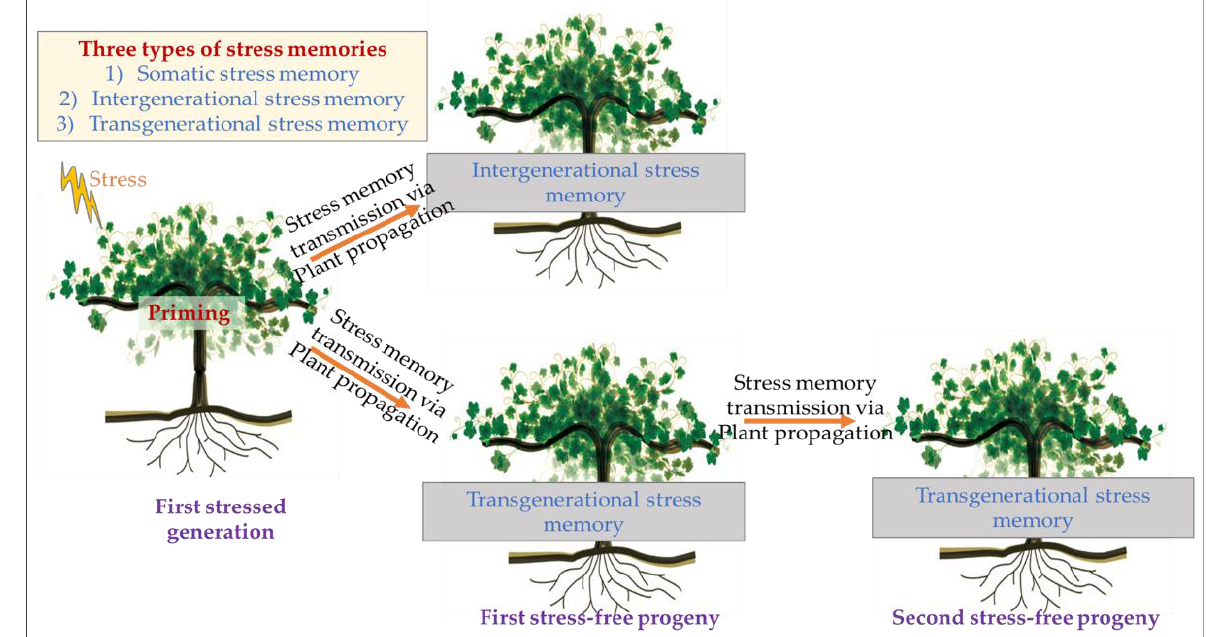
Figure 1. Overview of different types of stress memories in plants. Plants can be primed upon exposure to a stress event and priming enhances the plants’ tolerance to severe stress conditions. Priming-associated stress memory sometimes remain only within the first stressed generation of plants (somatic stress memory). In certain circumstances, intergenerational stress memories can be transmitted to the immediate progeny whereas transgenerational memory can be passed onto many downstream progenies.